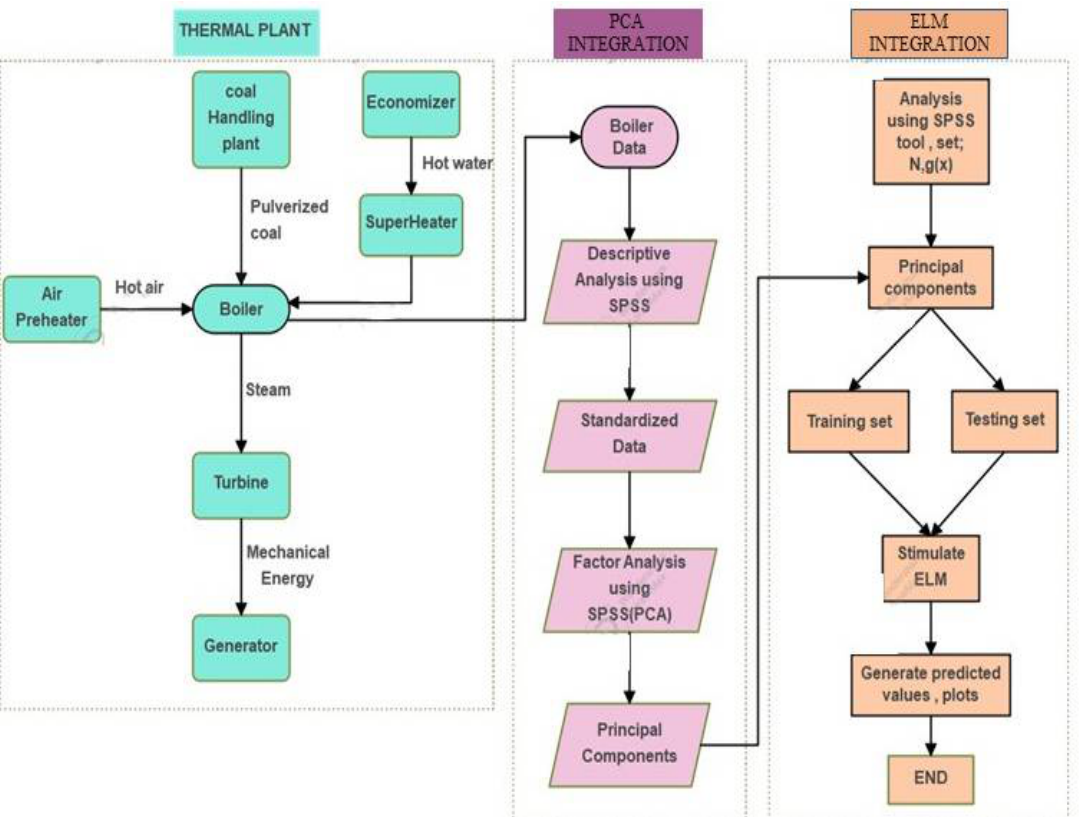
Figure 2. PCA–ELM Integration Approach.